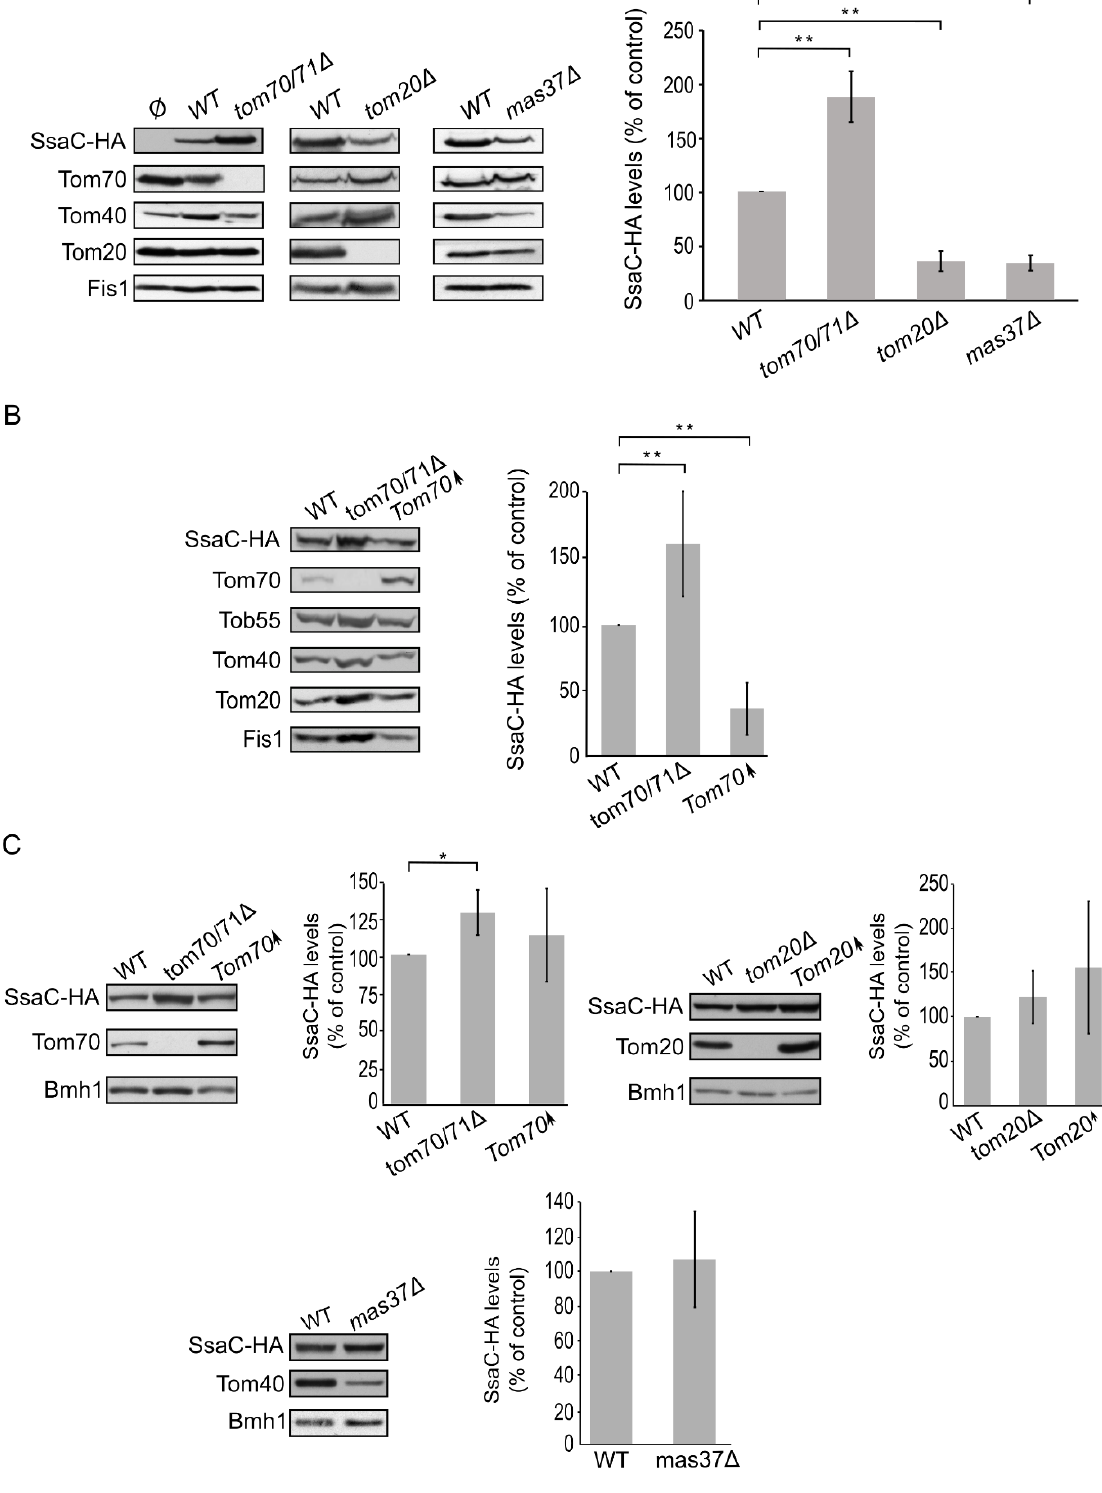
OPEN ACCESS | www.microbialcell.com 24 Microbial Cell | JANUARY 2020 | Vol. 7 No. 1